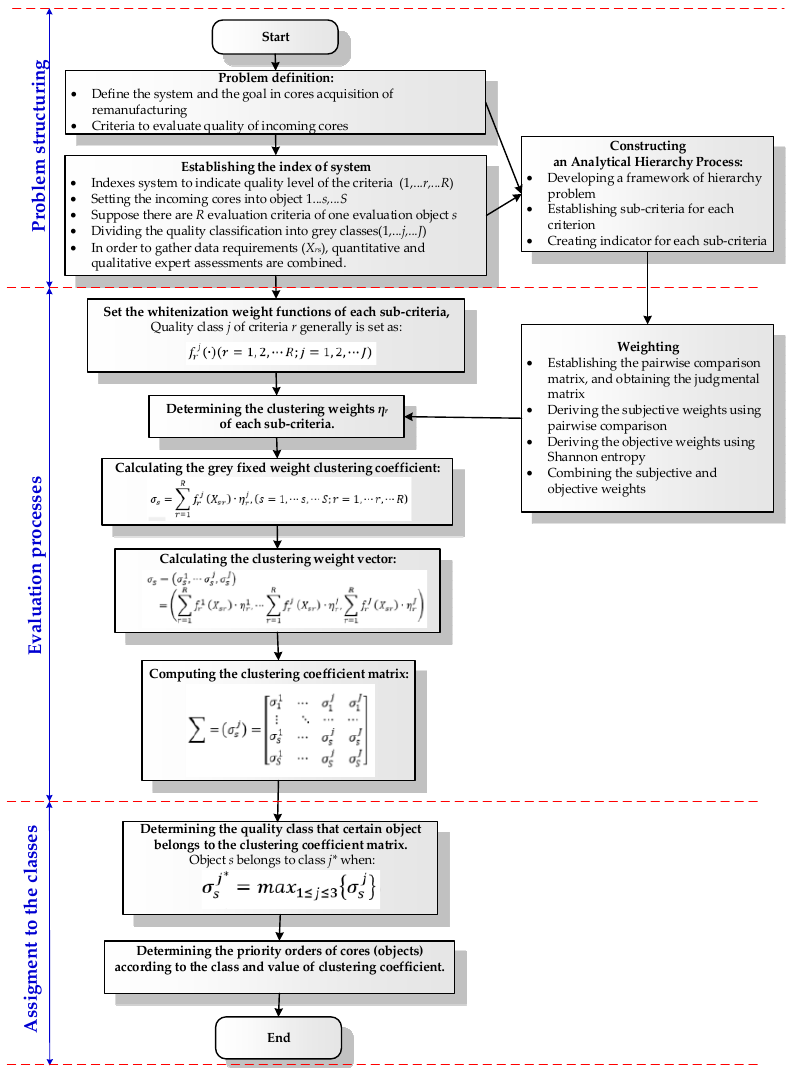
Figure 3. Flow diagram of the AHP grey clustering model for sorting.